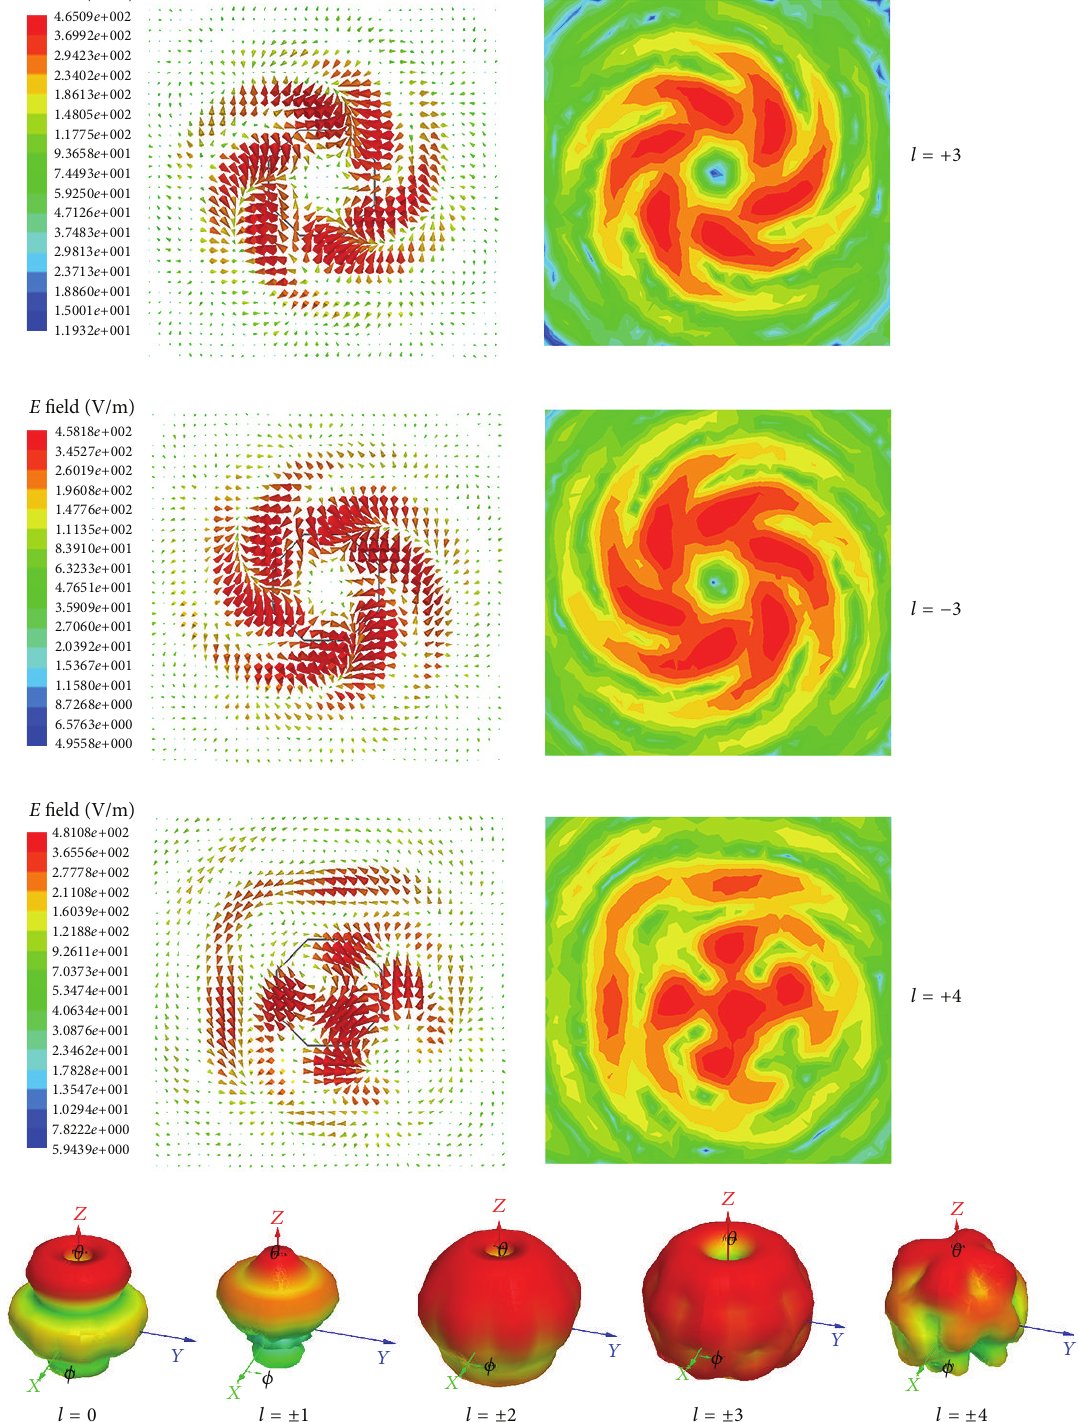
Figure 7: The vector and magnitude of electric field and 3D radiation patterns with different OAM states at